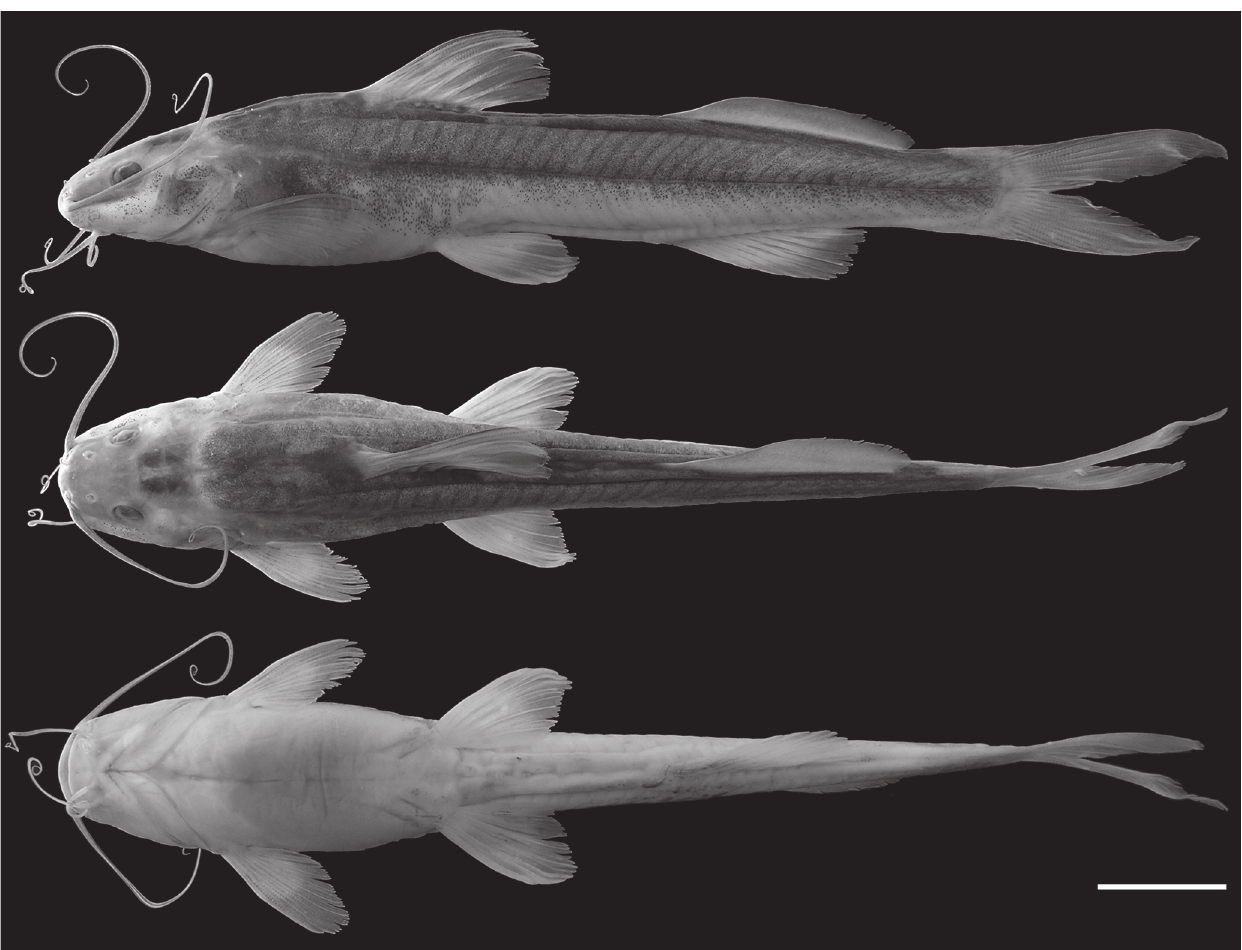
Fig. 1. Imparfinis timana , holotype, IAvH-P 10696, 74.2 mm SL, Colombia, Huila, Palestina, río Guarapas, in the mouth of quebrada La Quebradona, upper río Magdalena basin, 01º45’49”N 76º05’05”W. Scale bar = 1